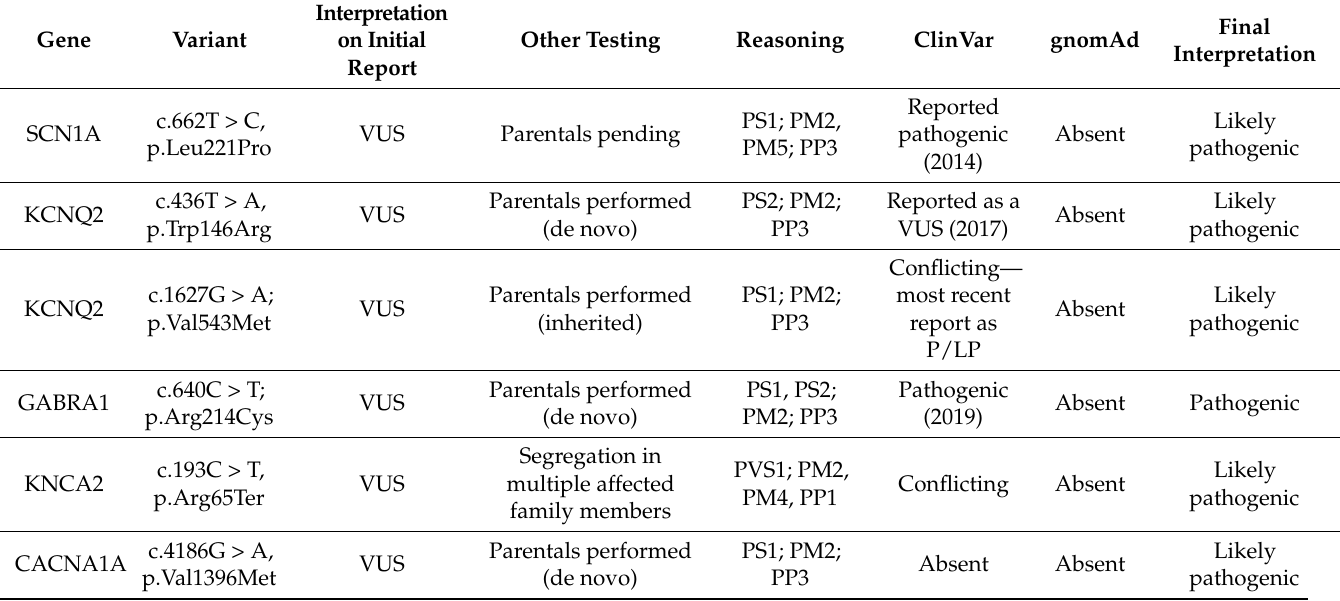
Table A2. VUS interpreted as pathogenic and included in